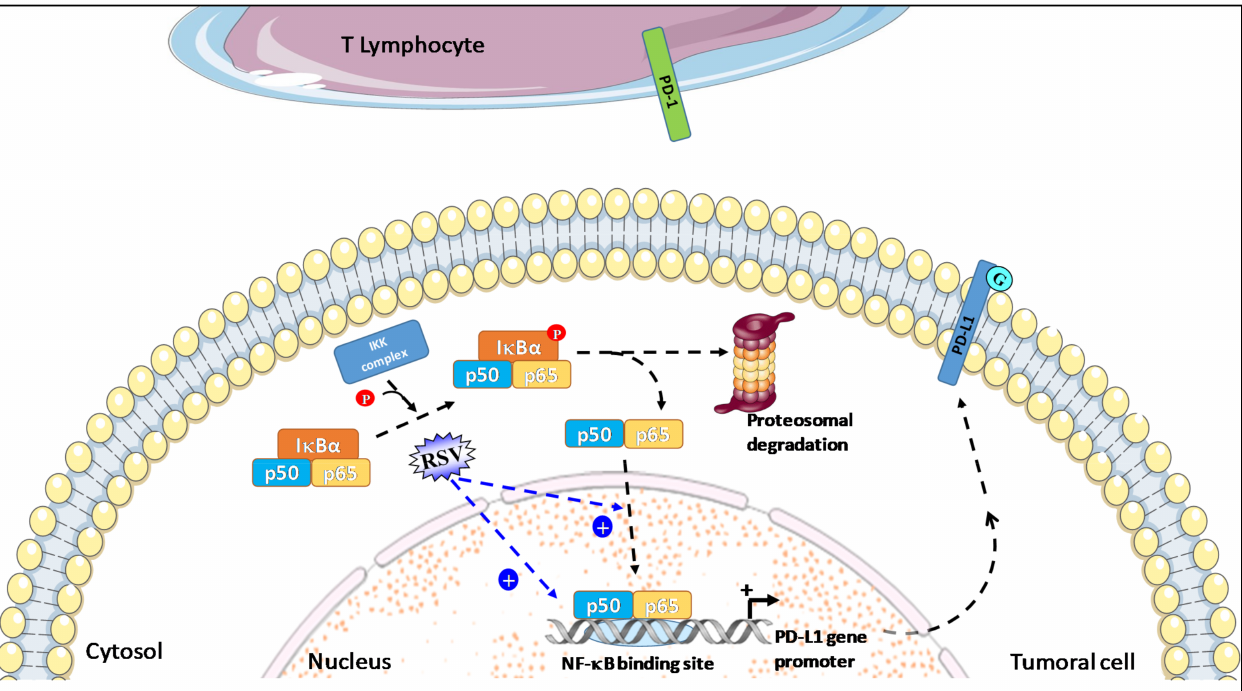
Figure 2. RSV used in combination with piceatannol leads to a synergistic induction of NF-kB expression and increases the translocation and nuclear accumulation of NF-kB p50 and p65 subunit in tumor cells. Activated NF-kB pathways then induce PD-L1 gene transcription by the binding of the p50 and p65 subunits to its promoter and can also regulate PD-L1